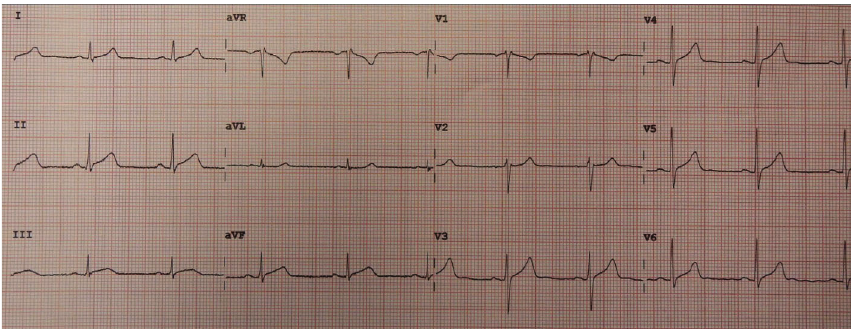
Figure 5: The patient ’ s electrocardiogram showed sinus rhythm, with PR segment elevation in lead aVR (12